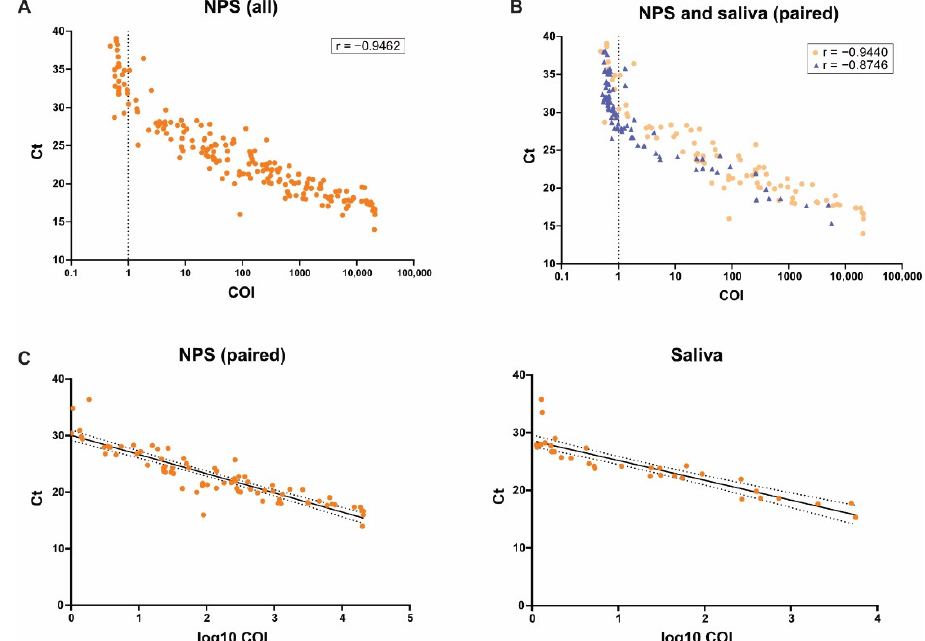
Figure 1. Analysis of correlation between Roche Elecsys Anti-SARS-CoV-2 Antigen assay and cobas SARS-CoV-2 IVD test for NPS and saliva samples and linear regression. Spearman correlation between Elecsys Anti-SARS-CoV-2 Antigen assay COI values ( X axis, log scale, cutoff indicated by dotted line) and cobas SARS-CoV-2 IVD test Ct values ( Y axis) was analyzed for all NPS (N = 187 *, p < 0.0001) ( A ) and paired NPS (orange circles, N = 87 *, p < 0.0001) and saliva samples (blue triangles, N = 87, p < 0.0001) ( B ). * Including one sample for which the ORF1-gene Ct value was used. Linear regression analysis of only positive antigen tests (COI values ≥ 1) was performed for NPS (left plot) and saliva (right plot); black solid line shows the regression line; dotted black lines show the 95% confidence bands ( C ).